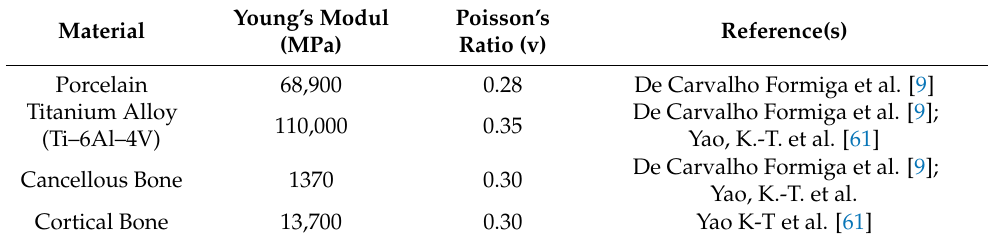
Table 1. Mechanical proprieties used in finite element